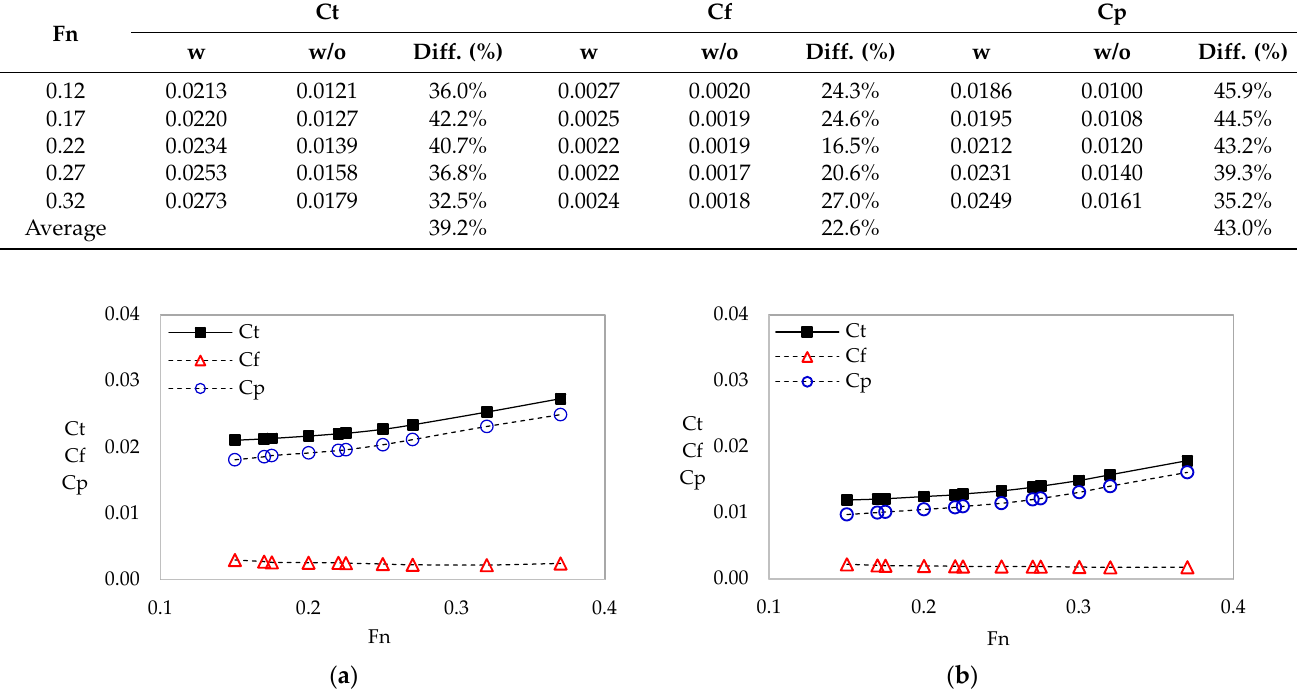
Figure 5. Components of resistance coefficient (Ct, Cf, and Cp): ( a ) w/ caterpillars, ( b ) w/o caterpillars.